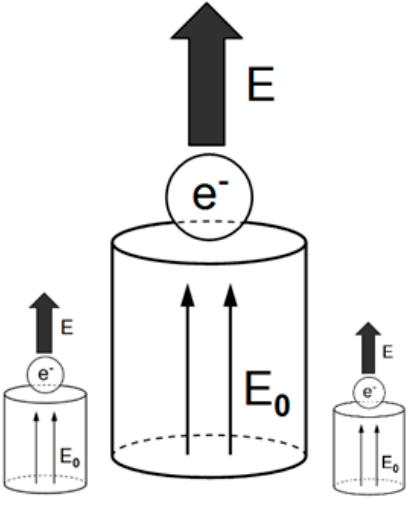
Figure 2. An electron attached to an electric vortex.